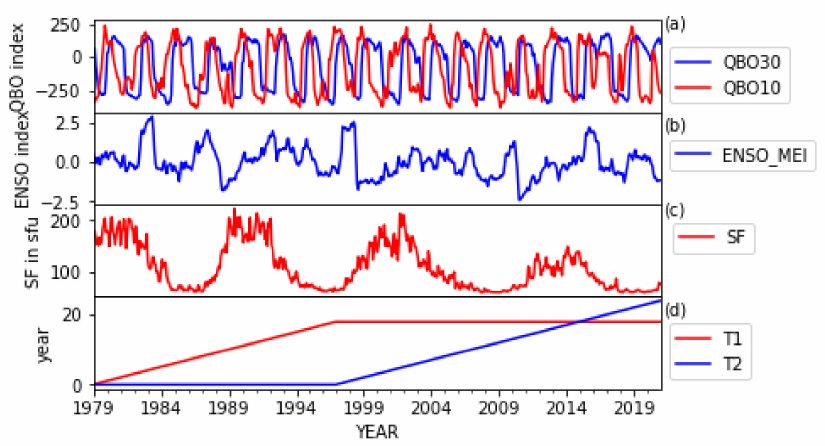
Figure 3. The Quasi-biennial Oscillation at 30 mb (QBO30) and 10 mb (QBO10) index ( a ), multivariate ENSO index version 2 ( b ), the Solar Flux (SF) index at a 10.7 cm wavelength in the SFU (Solar Flux Unit) with 1 sfu = 10 − 22 .m − 2 .Hz − 1 ( c ), and trend functions T1 and T2 (see Equation (3)) as a function of the year ( d